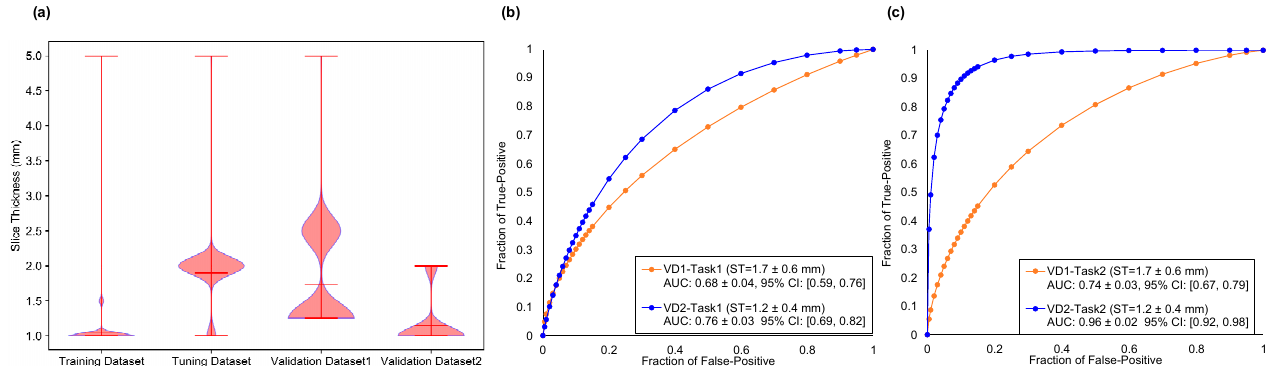
Figure 2. Comparisons of dataset slice thickness and ROC curves for two tasks. ( a ) The violin plots of slice thickness for four datasets. The ST is denoted as slice thickness. ( b ) The ROC curves for Task1 generated by DNN testing on validation dataset (VD) 1 and VD2, respectively. ( c ) The ROC curves for Task2 generated by DNN using testing on VD1 and VD2, respectively.